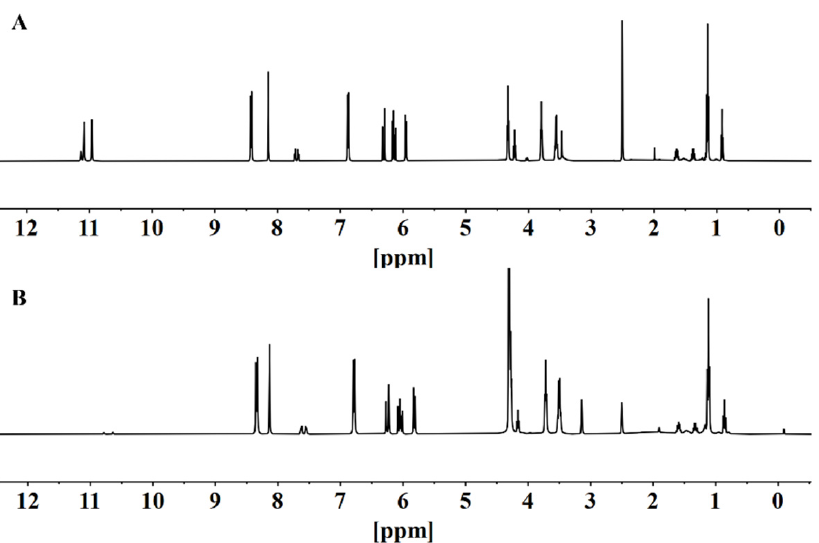
Figure 12. ( A ) 1 H NMR Spectrum of BNEA was measured in DMSO-d6, ( B ) 1 H NMR Spectrum of BNAE and Hg 2+ were measured in a mixed solvent (V DMSO-d6 :V CD4O = 1:1).